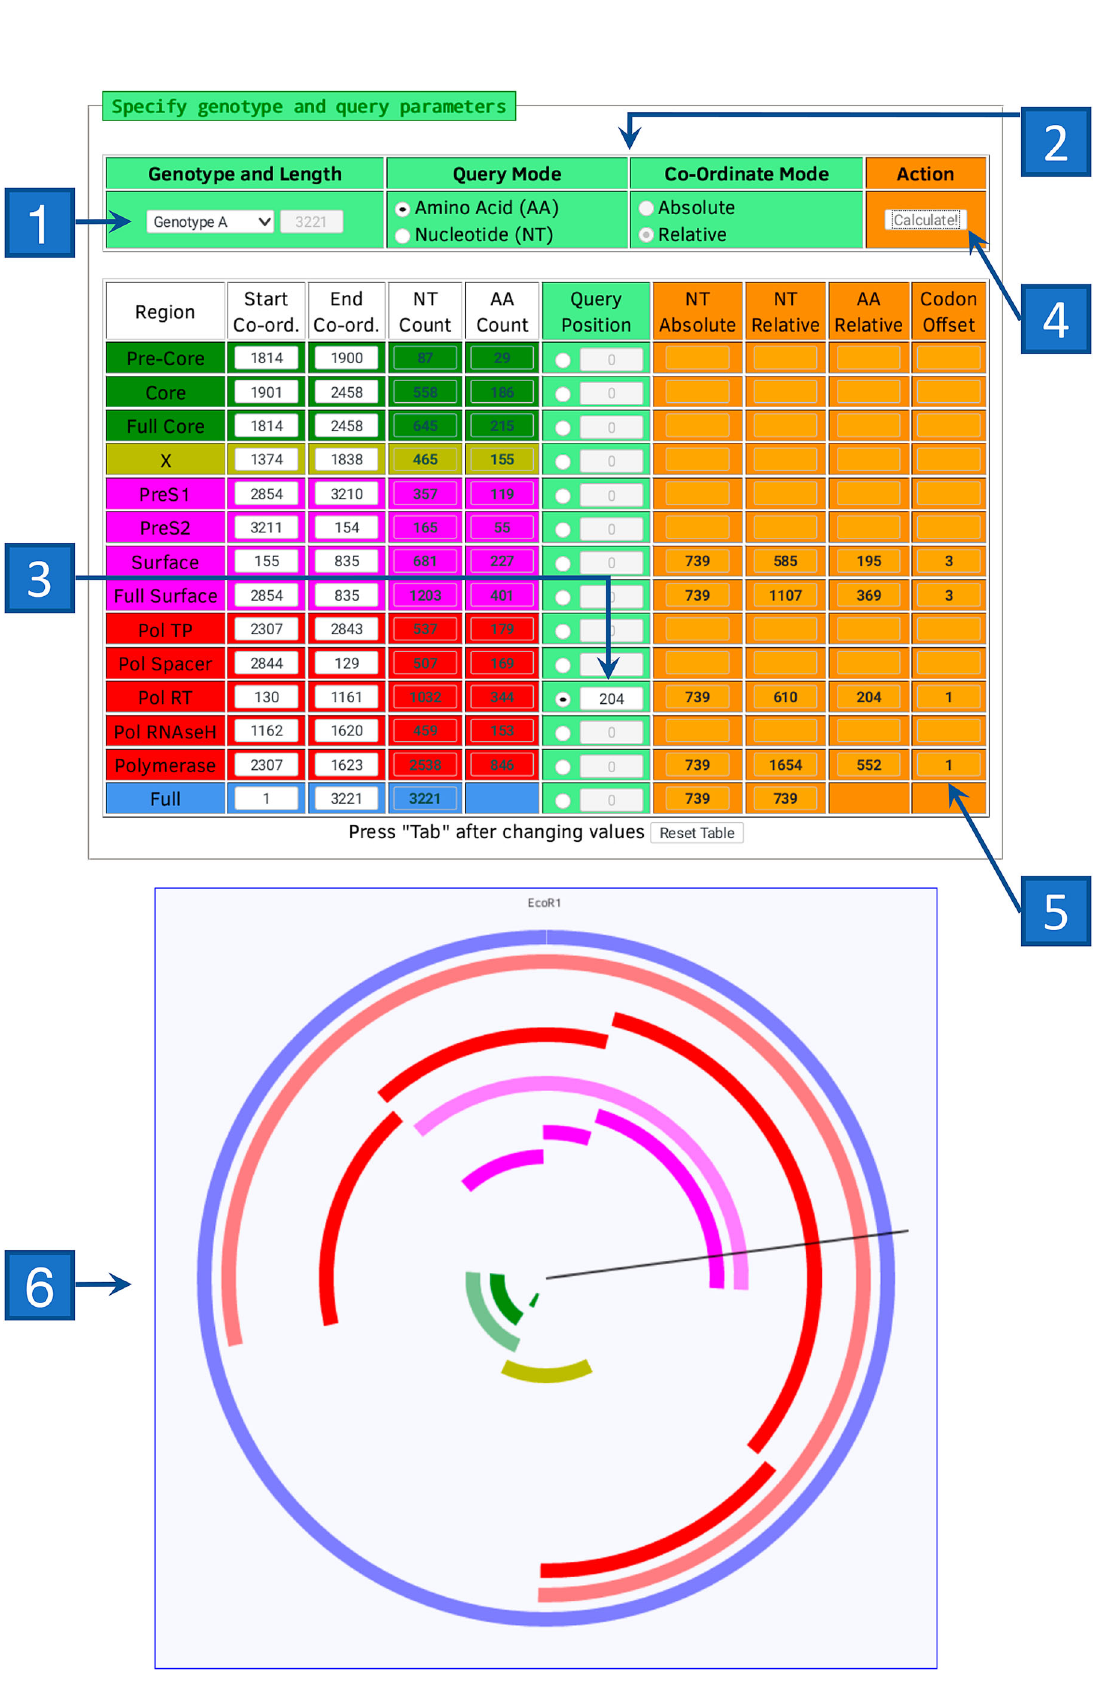
Figure 1: The coordinate conversion tool web page. Brie fl y, a genotype ( fl ag 1) and modes ( fl ag 2) are selected, the query position is input ( fl ag 3) and the ‘ Calculate ’ button ( fl ag 4) is pressed. Coordinate results ( fl ag 5) and diagrammatic position ( fl ag 6) are then shown. The ‘ query mode ’ indicates whether the query position entered represents an amino acid position or a nucleotide position. The ‘ co-ordinate mode ’ indicates whether the query position entered should be considered relative to position 1 of the genome ( Eco RI) or relative to the relevant ORF. Amino acid positions are always considered relative to the respective ORF. The four orange columns on the right of the table show the query position as an absolute and relative nucleo- tide position, and a relative amino acid position. The position of the nucleotide within the codon (position 1, 2 or 3 of the codon) is shown in the ‘ Codon Offset ’ column. When an amino acid position is entered, this will be a 1 for the speci fi ed ORF, as the fi rst nucleotide position of the amino acid is con- sidered. ORFs and regions in the diagram are colour-coded to match the colours used in the input table above. See text for detailed description of the